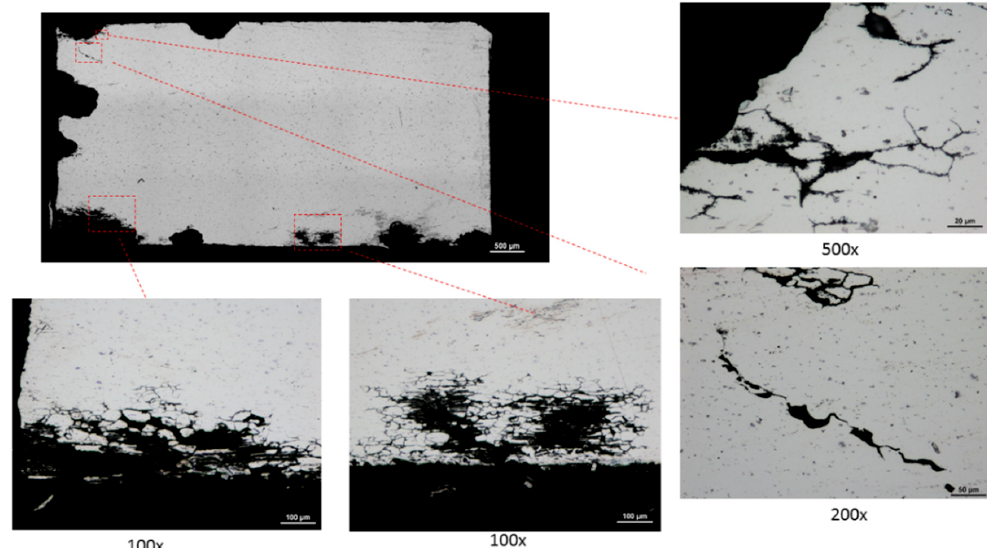
Figure 14. Metallographic section of wrought Al 6061-T6 stressed at 85% of yield strength after 90 days exposure to B117 salt fog testing. Various locations show pitting and intergranular crack branching.